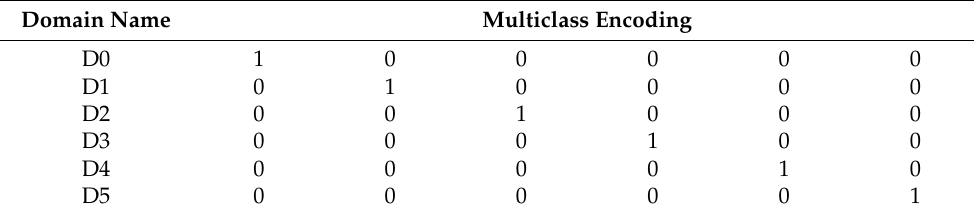
Table 3. Multiclass encoding of the output.